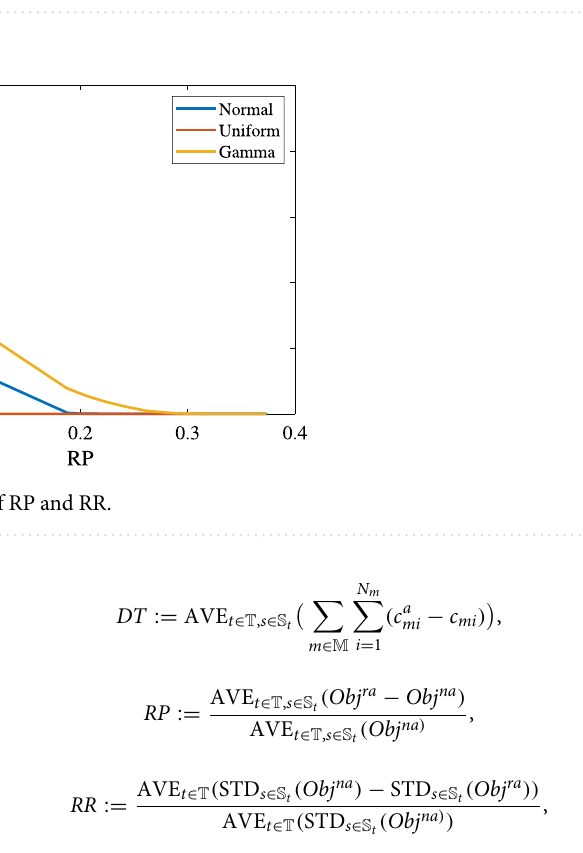
Table 5. Performance under different α s ( J = 20 ).